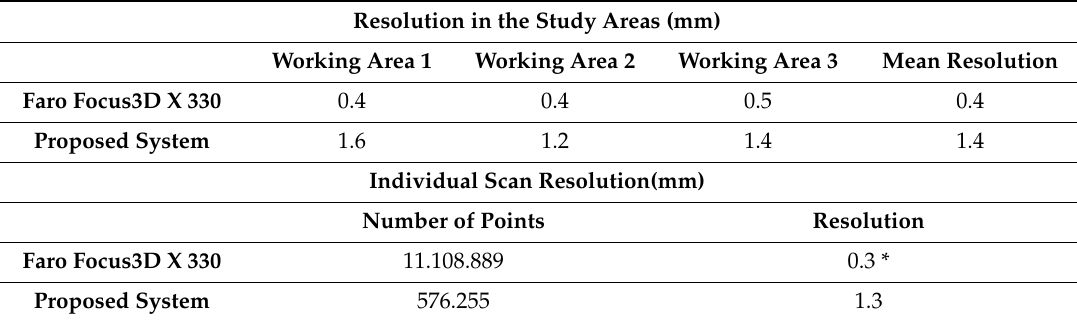
Table 3. Resolution of both systems in the work areas and resolution of an individual scan on a flat 1 m2 surface at 1 m distance. * according to manufacturer